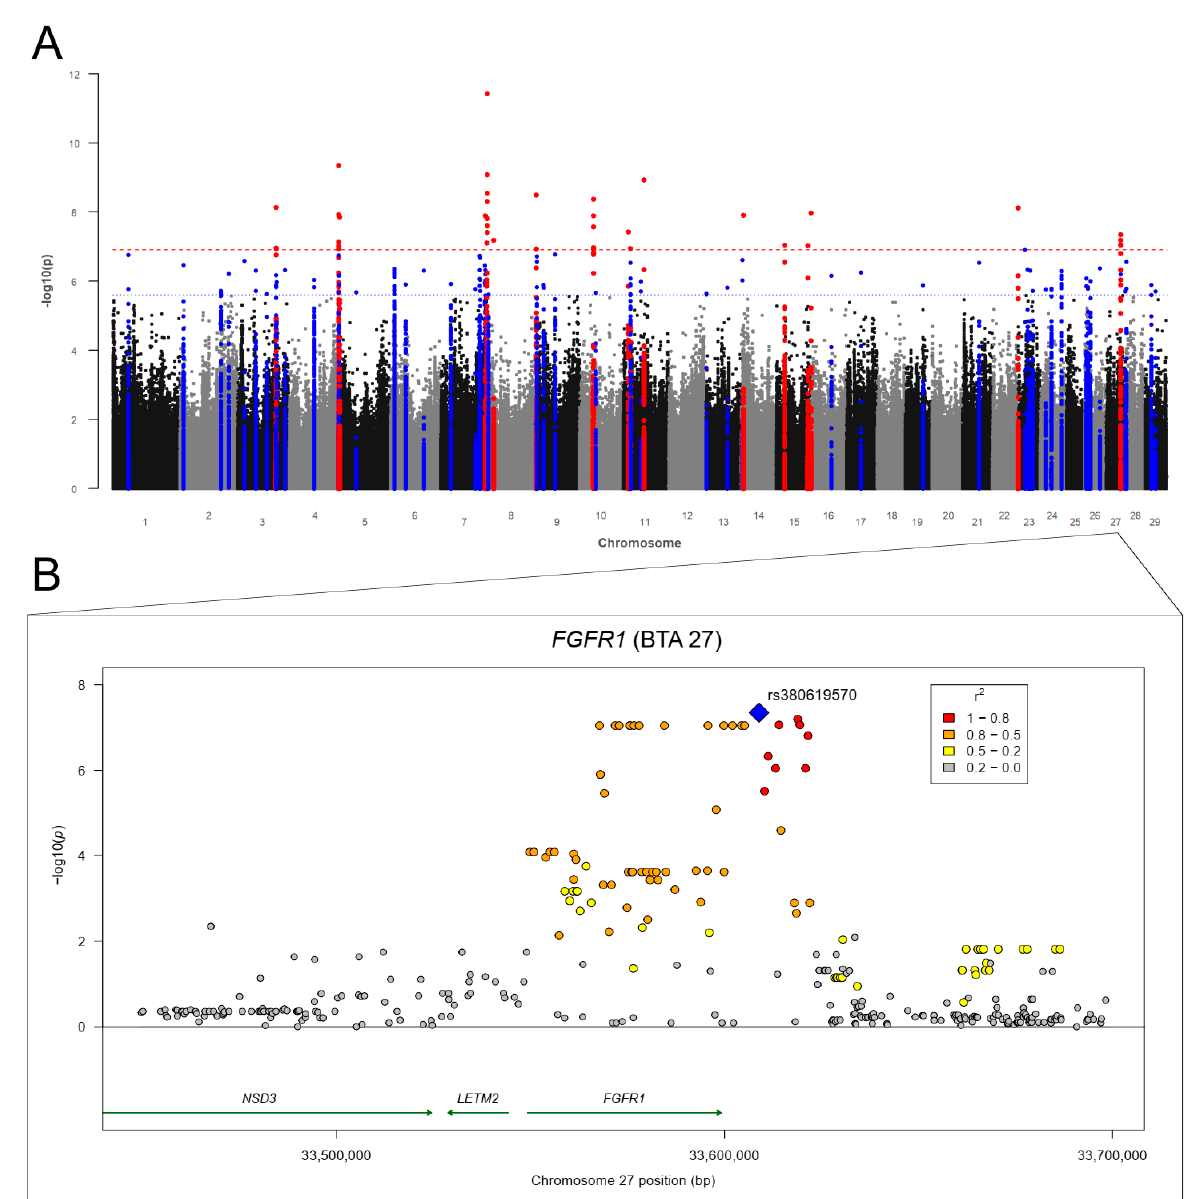
Figure 4. ( A ) Manhattan plot for − log10 p -values of marker effects for residuals of fecal egg counts of Fasciola hepatica (RES-FH); markers above the genome-wide significance threshold p Bonf (red dashed line) are highlighted in red and markers above the suggestive significance threshold p Sug (blue dashed line) are highlighted in blue. Markers within a distance of 125 kb up- and downstream of significantly or suggestively associated SVs are highlighted in red or blue, respectively. ( B ) Regional association plot for the fibroblast growth factor receptor 1 ( FGFR1 ) gene on BTA 27 with corresponding flanking regions (+/ − 100,000 bp). The SNP rs380619570 (blue square) was the highest associated SNP ( p = 4.48 × 10 − 8 ) for RES-FH on BTA 27. Circles show GWAS p -values, with different colors indicating linkage disequilibrium (LD): red: LD 0.8 to 1.0, orange: LD 0.5 to 0.8. yellow: LD 0.2 to 0.5, gray: LD 0.0 to 0.2. Genes with a green arrow pointing to the right are located on the forward strand, genes with an arrow pointing to the left are located on the reverse strand.